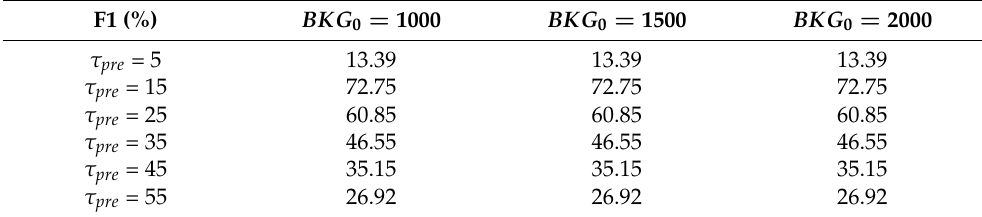
Table 7. LTS algorithm tuning. F1 index vs. τ pre and BKG 0 . The first threshold varies along the rows from 5 to 55, while the second one varies along the columns from 1000 to 2000.